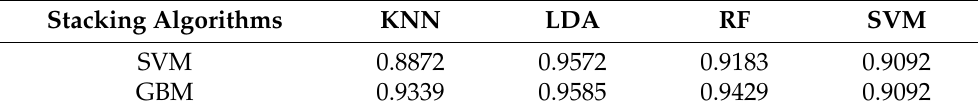
Table 11. Accuracy values of stacking algorithms for the evaluation protocol 2.